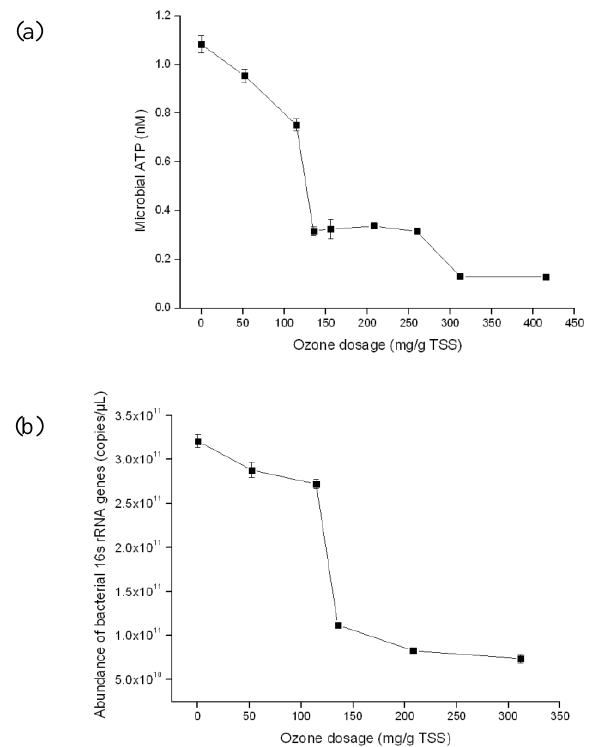
Figure 3. Viable bacterial biomass in activated sludge under different ozone dosages: ( a ) microbial ATP concentration; and ( b ) bacterial 16S rRNA gene copies.